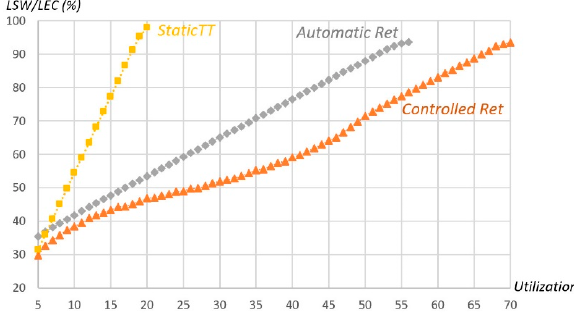
Figure 11. Average requirement for minimum LSW vs message set bandwidth utilization.